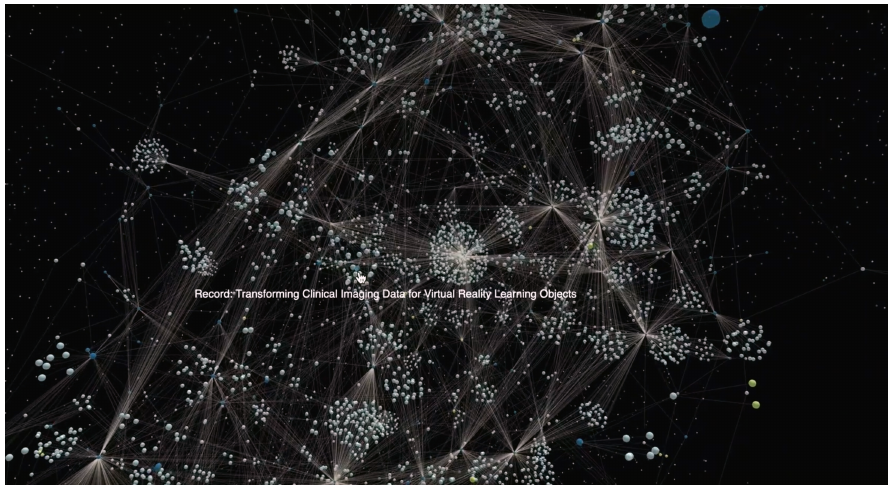
Figure 5. 3D Fruchterman–Reingold visualization of bibliographic